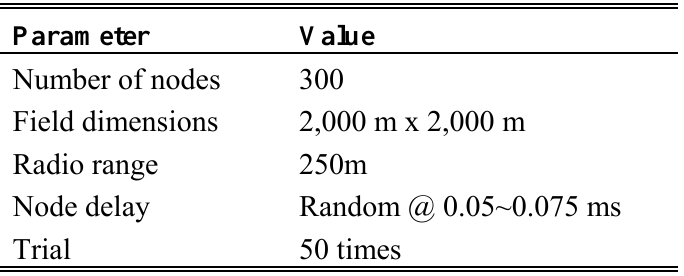
Table 2. Parameters for